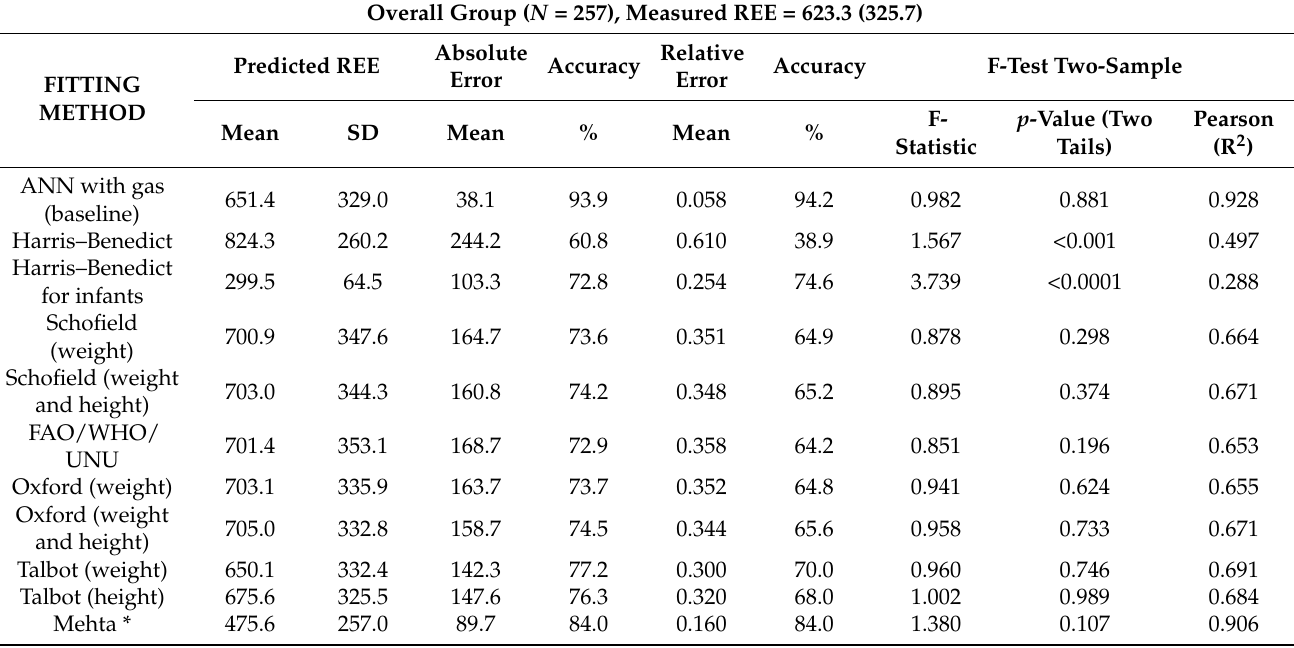
Table 2. Fitting performances of true REE by the tests under